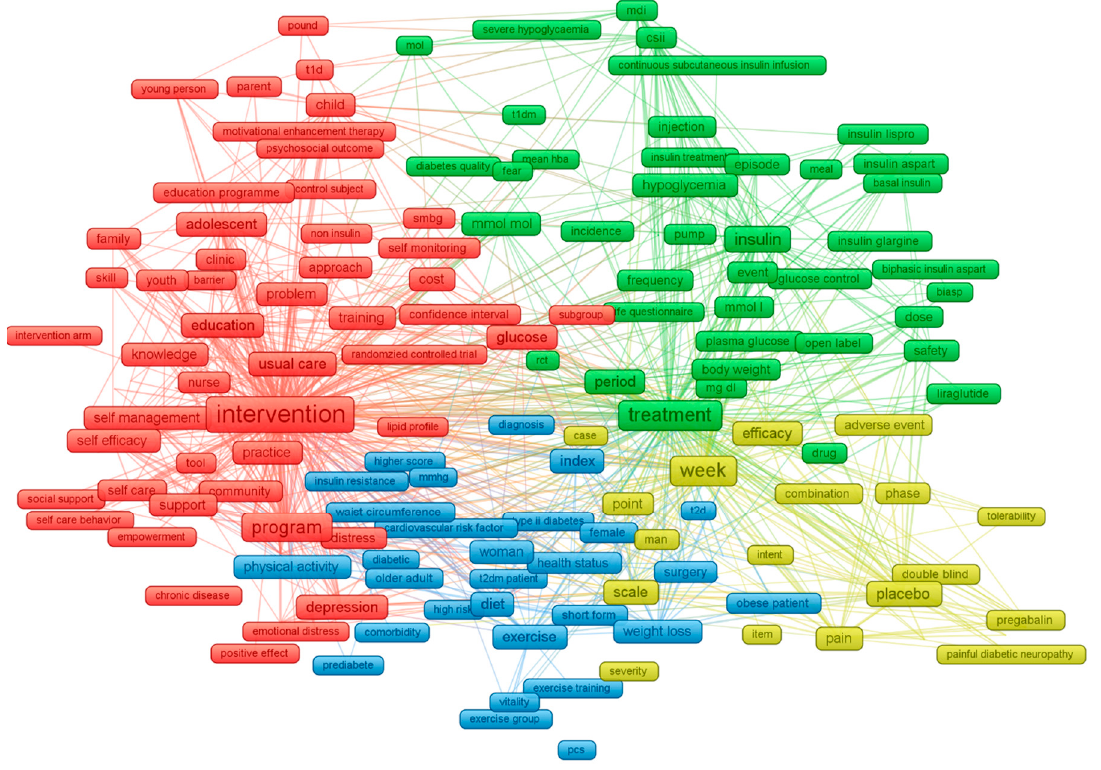
Figure 3. Co-occurrence of most frequent terms in titles and abstracts. The colors of the nodes indicate principal components of the data structure; the node size was scaled to the keywords’ occurrences; the thickness of the lines was drawn based on the strength of the association between two keywords.